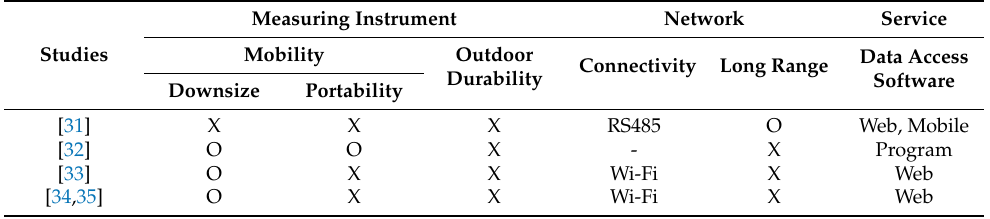
Table 2. Studies on IoT-based PM monitoring systems.